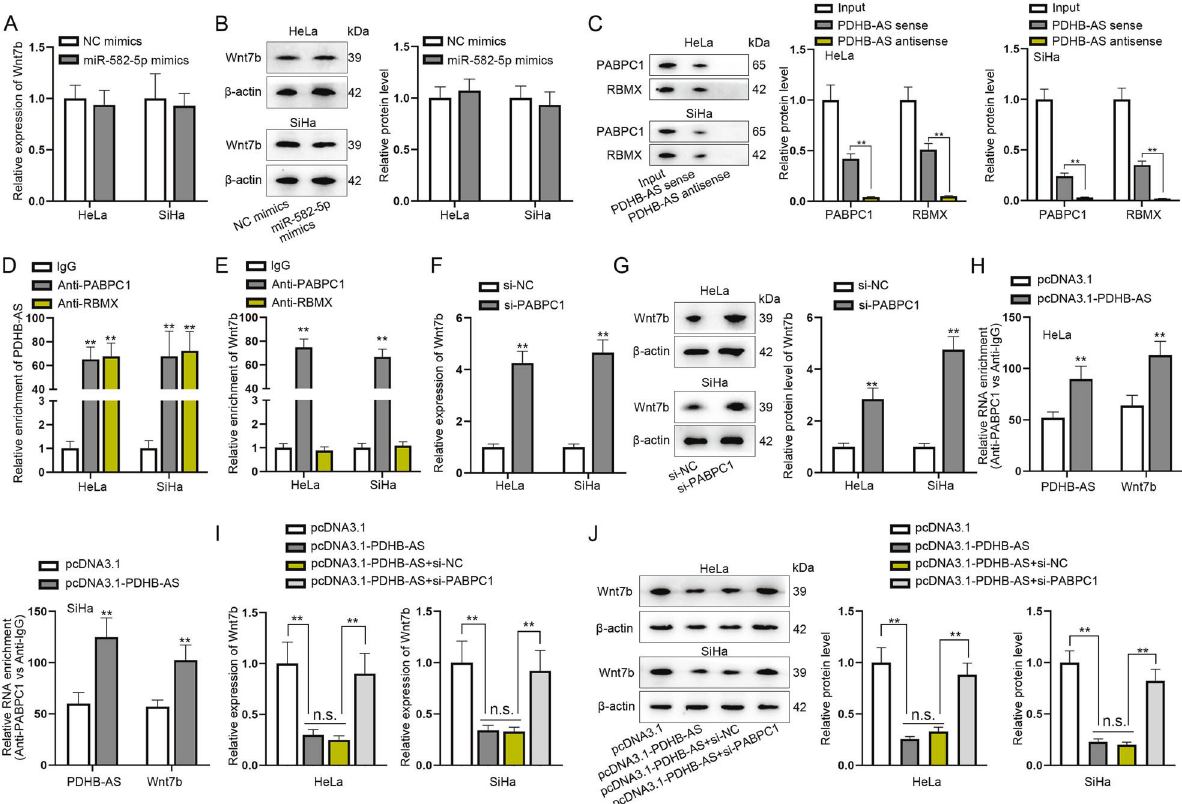
Fig. 5 PDHB-AS recruits PABPC1 to modulate Wnt7b expression. A , B The mRNA and protein levels of Wnt7b were measured respectively by RT-qPCR and western blot after miR-582-5p overexpression. C PABPC1 and RBMX were ascertained to bind to PDHB-AS by RNA pull down assays and mass spectrometry, followed by western blot to detect PABPC1 and RBMX protein levels precipitated in PDHB-AS sense/antisense, with input as a positive control. D , E In RIP assay, the relative enrichment of PDHB-AS and Wnt7b in anti-PABPC1 and anti-RBMX groups was detected via RT-qPCR, with IgG as a negative control. F , G The mRNA and protein levels of Wnt7b were examined respectively by RT-qPCR and western blot after knockdown of PABPC1. H In RIP assay, the relative enrichment of PDHB-AS or Wnt7b precipitated in anti-PABPC1 was measured in cells transfected with pcDNA3.1 or pcDNA3.1-PDHB-AS, respectively. I , J RT-qPCR and western blot analyses of Wnt7b levels were performed in HeLa and SiHa cells transfected with pcDNA3.1, pcDNA3.1-PDHB-AS, pcDNA3.1-PDHB-AS + si-NC, or pcDNA3.1-PDHB-AS + si- PABPC1. ** P < 0.01, n.s.: no signi fi